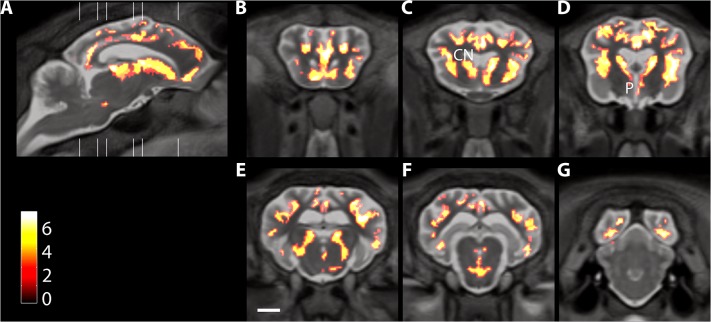
Representative sections showing significant differences in longitudinal rates of change between control and Batten disease affected sheep.Significant changes in Batten disease sheep are shown on representative pseudocoloured sagittal and coronal sections. White lines on the sagittal section indicate the position of the coronal sections on the right. Colour bar indicates Student’s t-score with seven degrees of freedom. All changes shown are significant at p < 0.05 adjusted for multiple comparisons by controlling the false-discovery rate. Scale bar in E is 1 cm. (The full data set is shown in S2 Fig.)